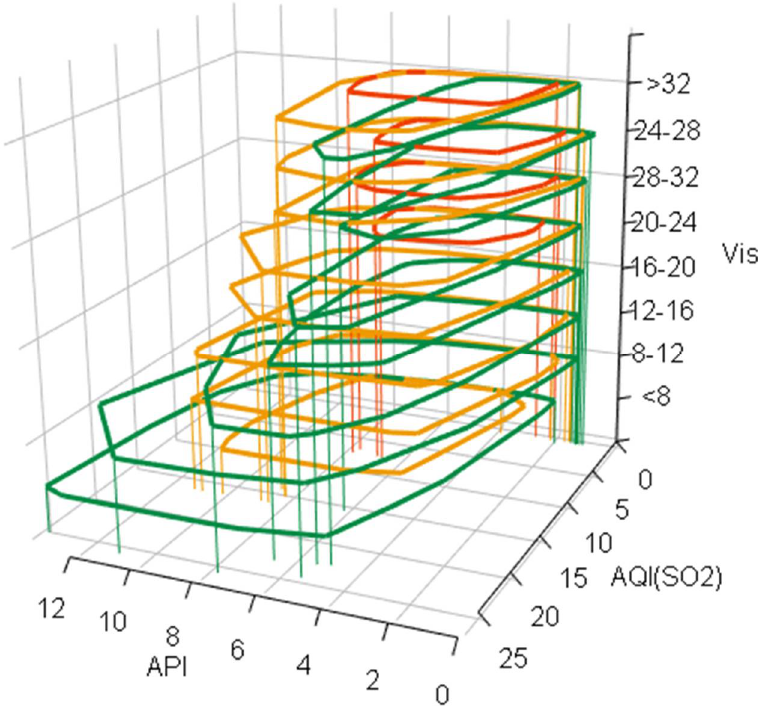
Figure A12. Effect of visibility-dependent air concentrations of SO 2 on the air pollution index for the spring, summer and winter dry periods.